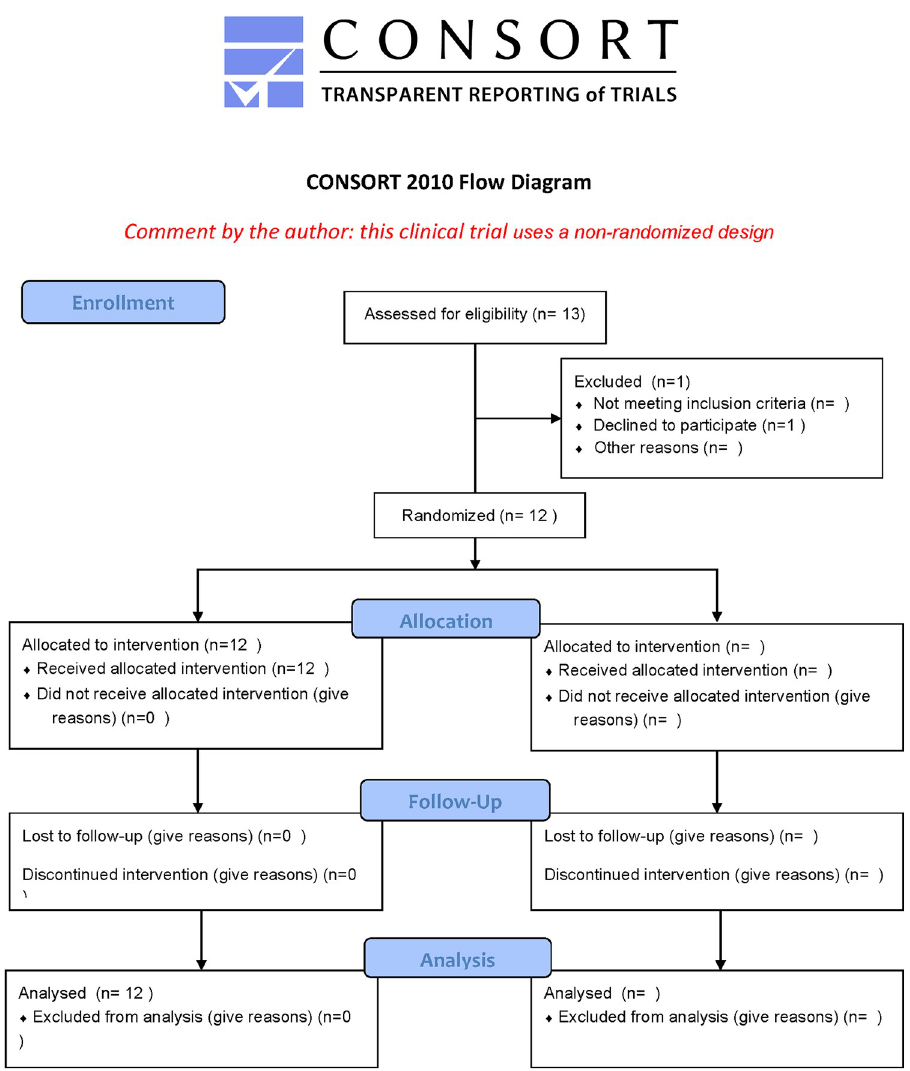
Fig 4. Flow chart displaying non-randomized design of